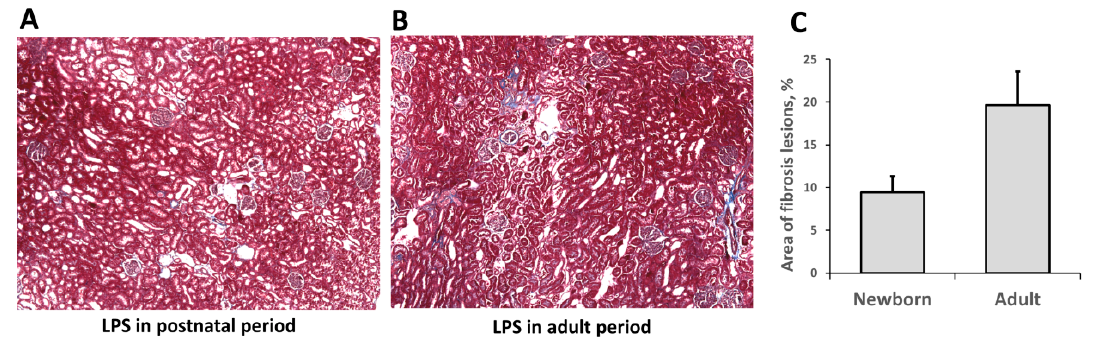
Figure 6. Histological evaluation of fibrotic changes in neonatal and adult kidneys two months after LPS treatment. ( A ) Kidneys of rats that received LPS in neonatal age and ( B ) kidney of rats treated with LPS in adult age. ( C ) Evaluation of fibrotic lesions revealed increased fibrosis in adult group. Number of animals: Adult ( n = 3), Newborn ( n = 3).